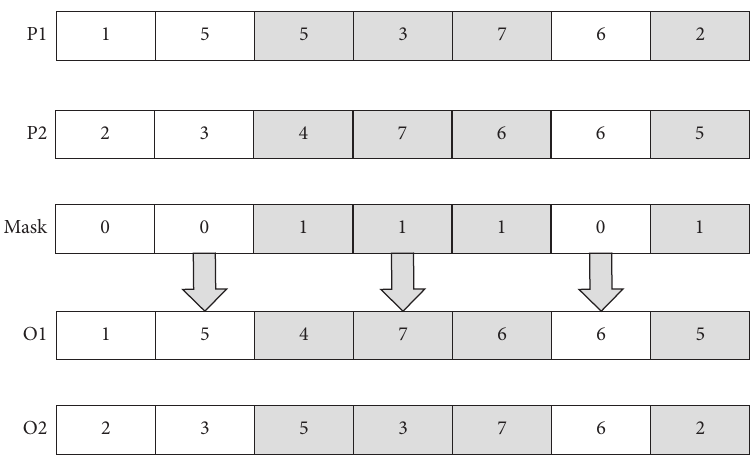
Figure 3: Schematic diagram of high-level chromosome crossover.